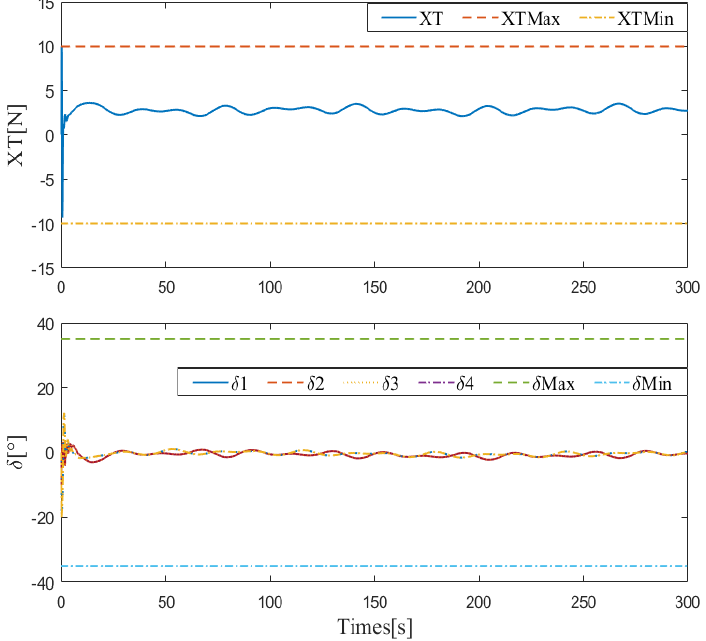
Figure 14. The control inputs of proposed method.